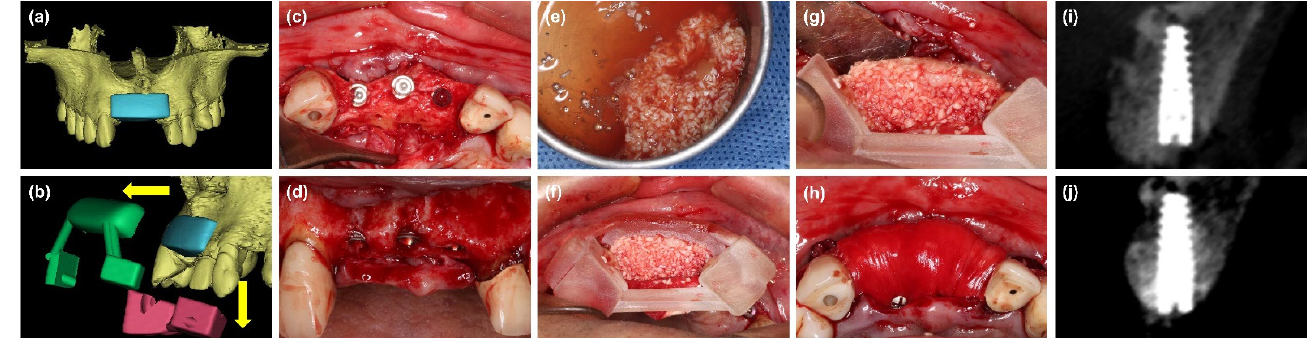
Figure 3. ( a ) Digital simulation of the bone graft contour before surgery. ( b ) A two-piece surgical template, which consists of two parts: the coronal part (red) for retention and the labial part (green) for shaping the bone grafts, was fabricated based on the digital model. the template can be removed without disrupting the graft material. ( c , d ) The labial defect could be observed. ( e ) Particulate bone substitutes were mixed with i-PRF. ( f , g ) The mixture of i-PRF and particulate bone substitutes was placed into the defect under the guidance of the surgical template. ( h ) The customized i-PRF block was covered with a collagen membrane and fixed with pins. ( i ) Radiographic cone-beam CT view immediately after wound closure. ( j ) Radiographic cone-beam CT view at 6 months.